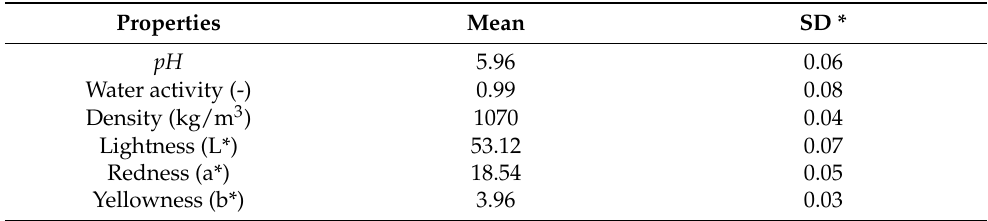
Table 1. The physical properties, pH , water activity, density, and color components of fresh camel meat. Properties